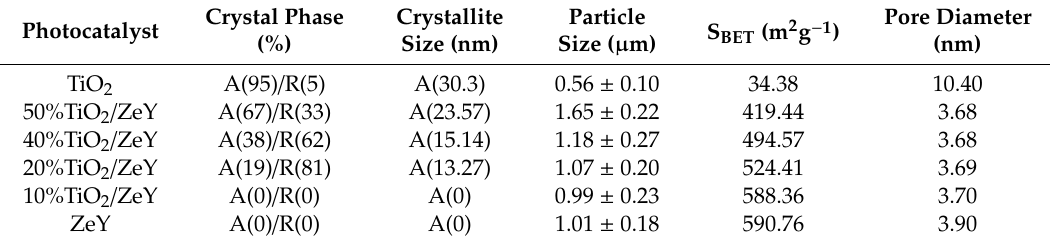
Figure 1. SEM images of ( a ) ZeY, ( b ) 10%TiO 2 / ZeY, ( c ) 20%TiO 2 / ZeY, ( d ) 40%TiO 2 / ZeY, ( e ) 50%TiO 2 / ZeY, and ( f ) TiO 2 . Table 1. Summary of crystal phases, crystallite sizes, particle sizes, specific surface areas (S BET ), and pore diameters of TiO 2 , TiO 2 / ZeY (10, 20, 40 and, 50 mol % of TiO 2 compared with ZeY), and ZeY.